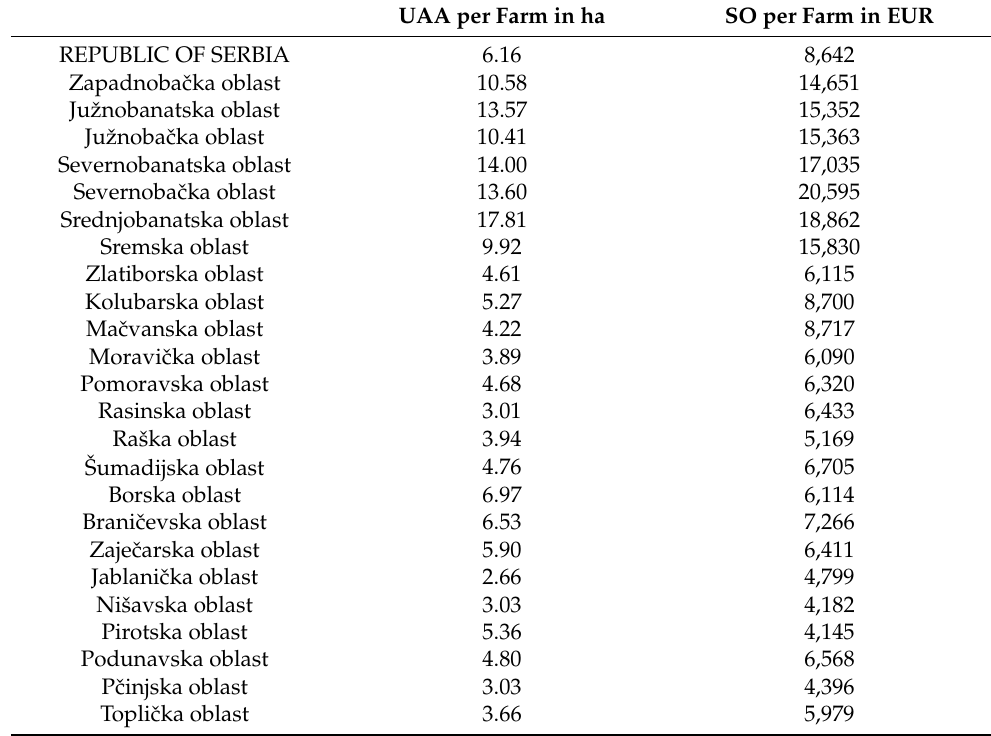
Table A2. Farm structure in the Republic of Serbia on the NUTS 3